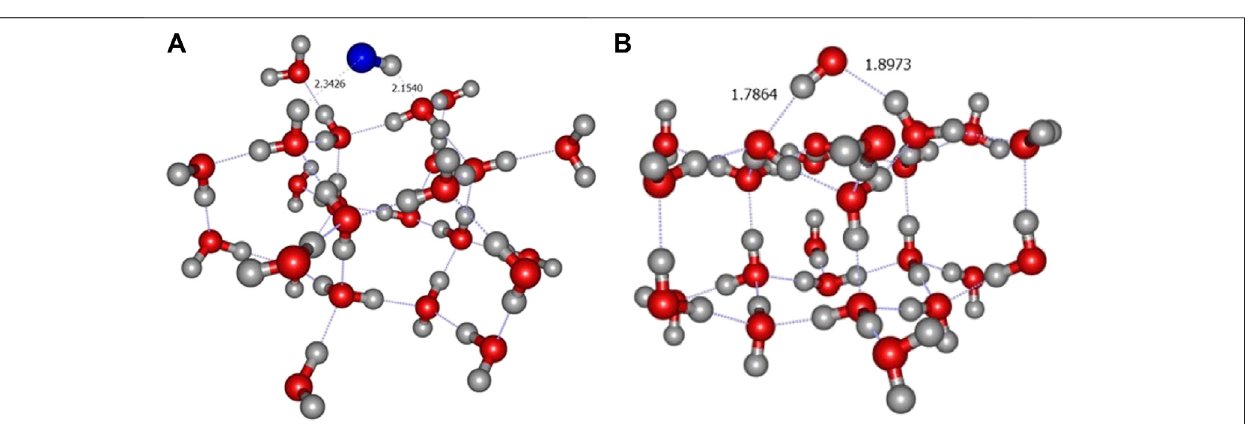
FIGURE 5 | ONIOM( ω B97X-D/6-31+G**:PM6) most stable geometry for NH (A) and OH (B) molecules (A2 site) on crystalline ice.